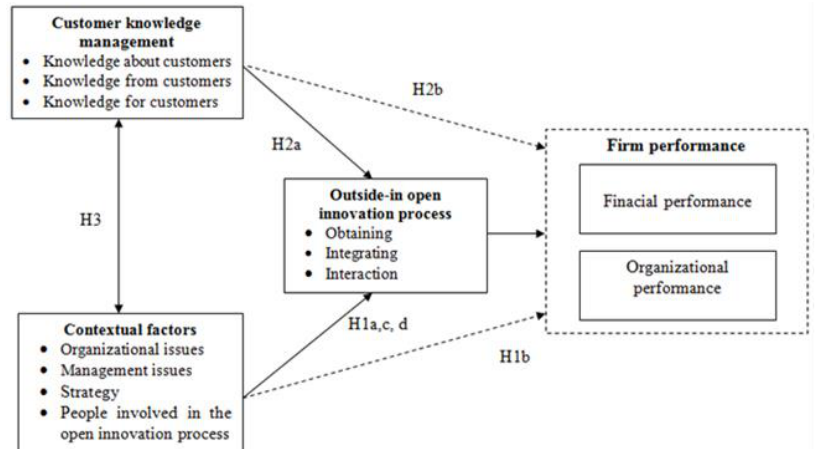
Fig. 3. Theoretical model of outside-in open innovation process and it’s assumptions of customers knowledge